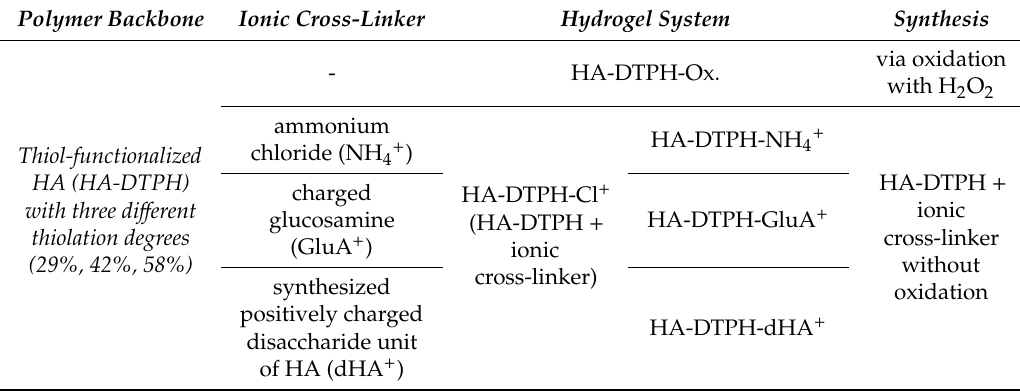
Table 3. Overview of used hydrogel systems with additionally used ionic cross-linker (including abbreviation for each ionic